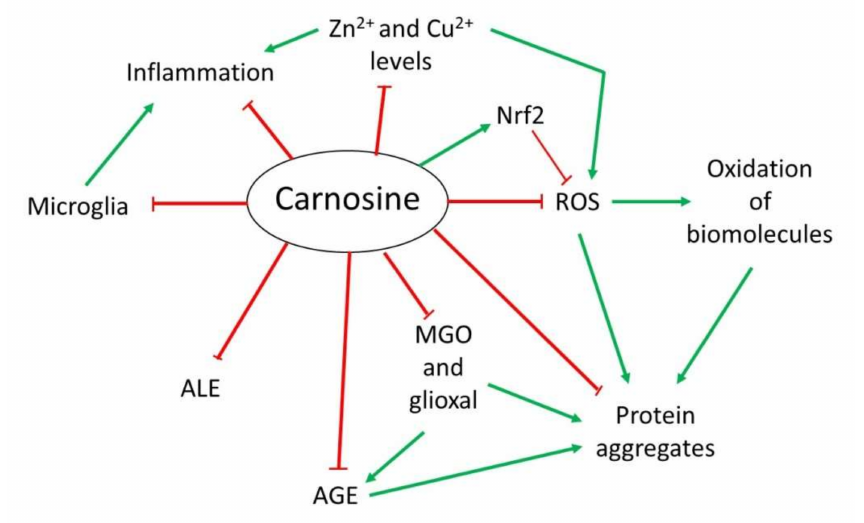
Figure 2. Overview of the mechanism of action of carnosine as antioxidant, anti-aggregant, anti- glycation and anti-inflammatory